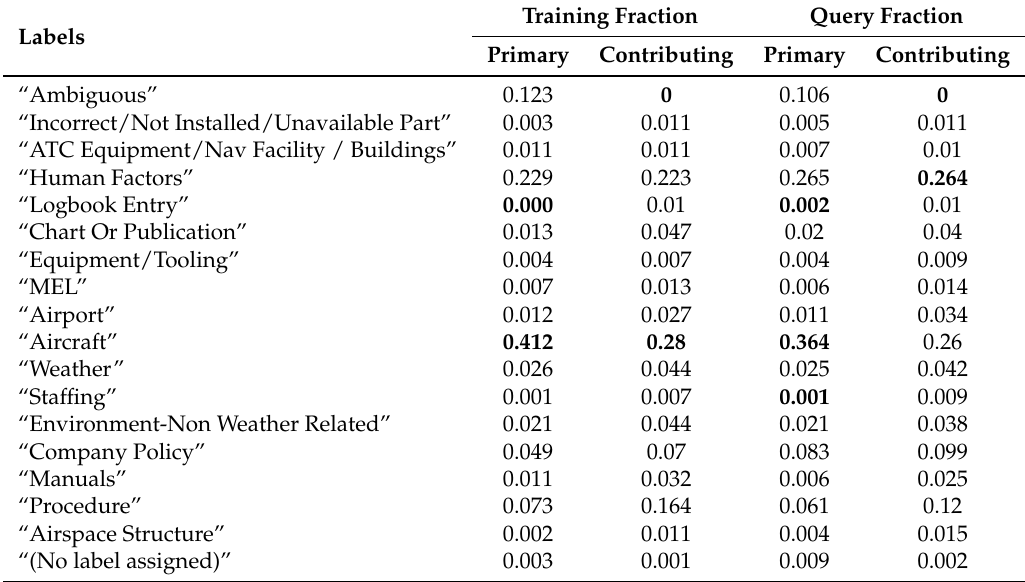
Table 1. The fractional portion of each label in the training and query datasets. Extrema of each column are shown in bold